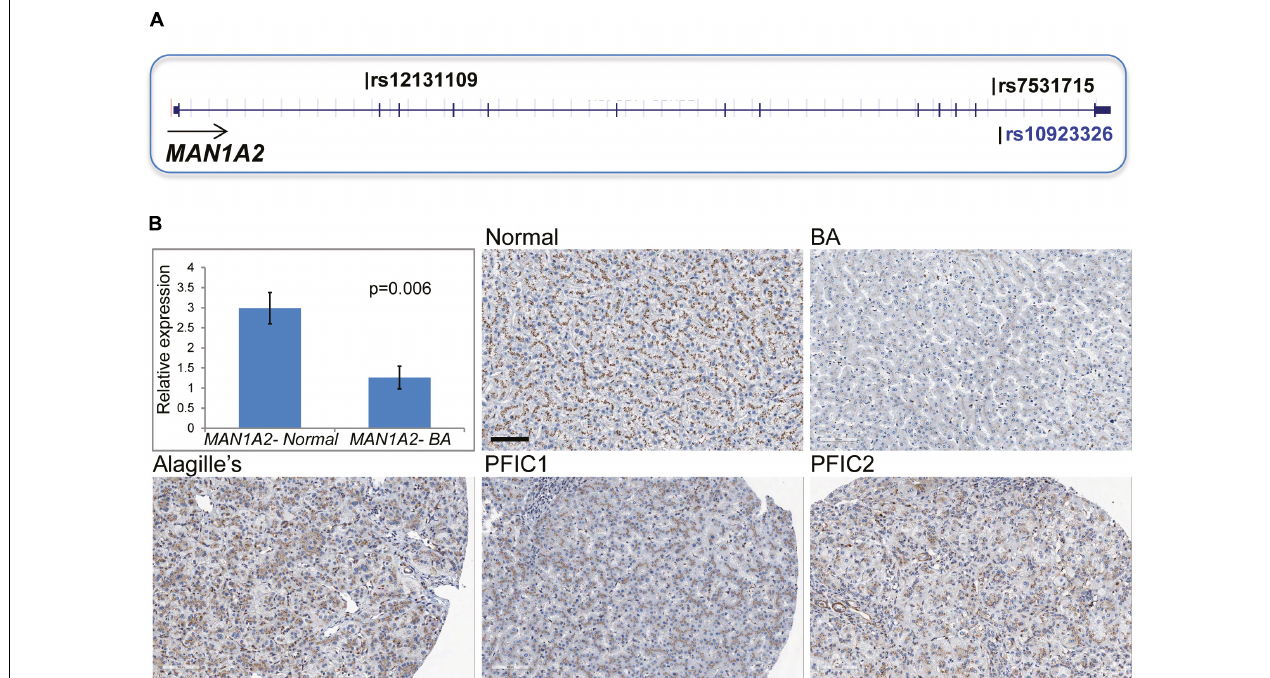
FIGURE 1 | (A) Location of MAN1A2 SNPs associated with BA. The SNPs rs7531715 and rs12131109 are associated with BA in GWAS. The SNP rs10923326 in LD (r2 = 1) with rs7531715 is significantly associated with gene expression in the liver. (B) MAN1A2 expression in diseased BA liver. Bar diagram shows expression of the exon 6 and 7 region of MAN1A2 in liver tissue from BA cases [male: female 1:5, mean (SEM) age at LTx, 1.33 (0.55) years] and healthy controls. The remaining five panels show diffuse strong (3+) granular immunostaining of MAN1A2 in the hepatocyte cytoplasm along pericanalicular membranes in normal human allografts, and liver from children with Alagille’s syndrome and types 1 and 2 progressive familial intrahepatic cholestasis (PFIC). Reduced MAN1A2 immunostaining is seen in BA liver